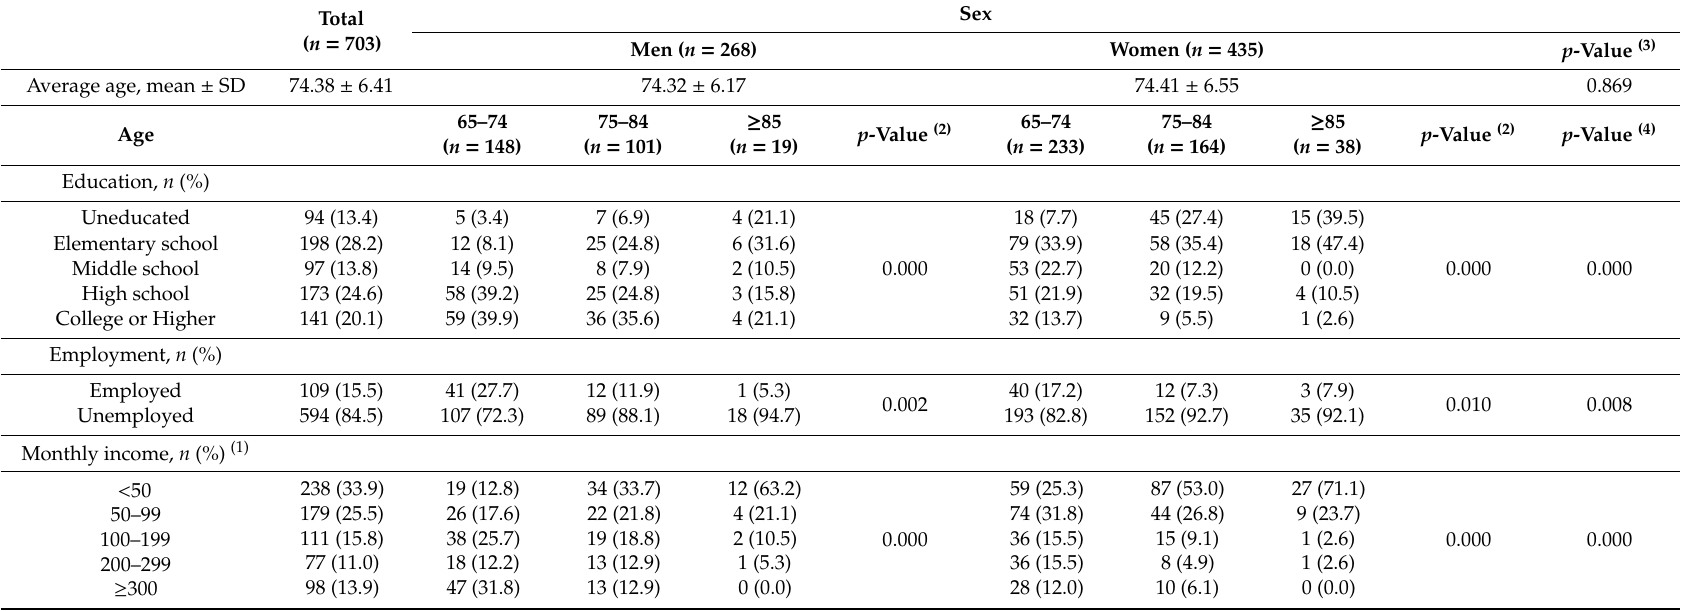
Table 1. General characteristics of the subjects by